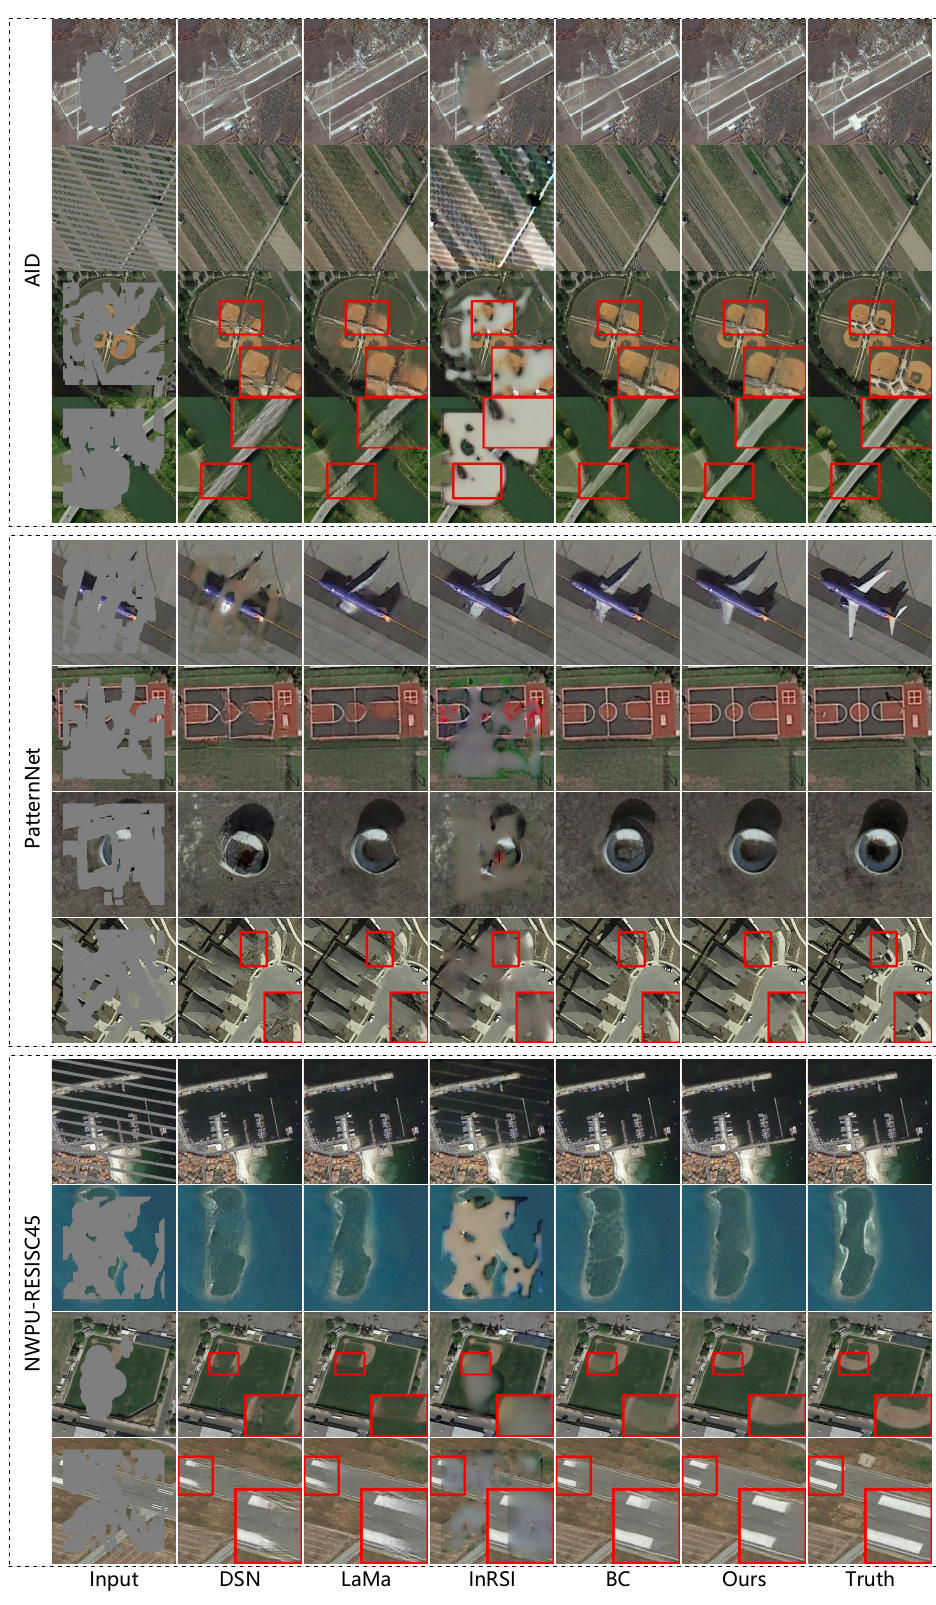
Figure 5. Visualization results with DSN [5], LaMa [44], InRSI [2], BC [43], and ours on three remote sensing datasets. Local details of the results are displayed in red boxes, and it is recommended to zoom in for